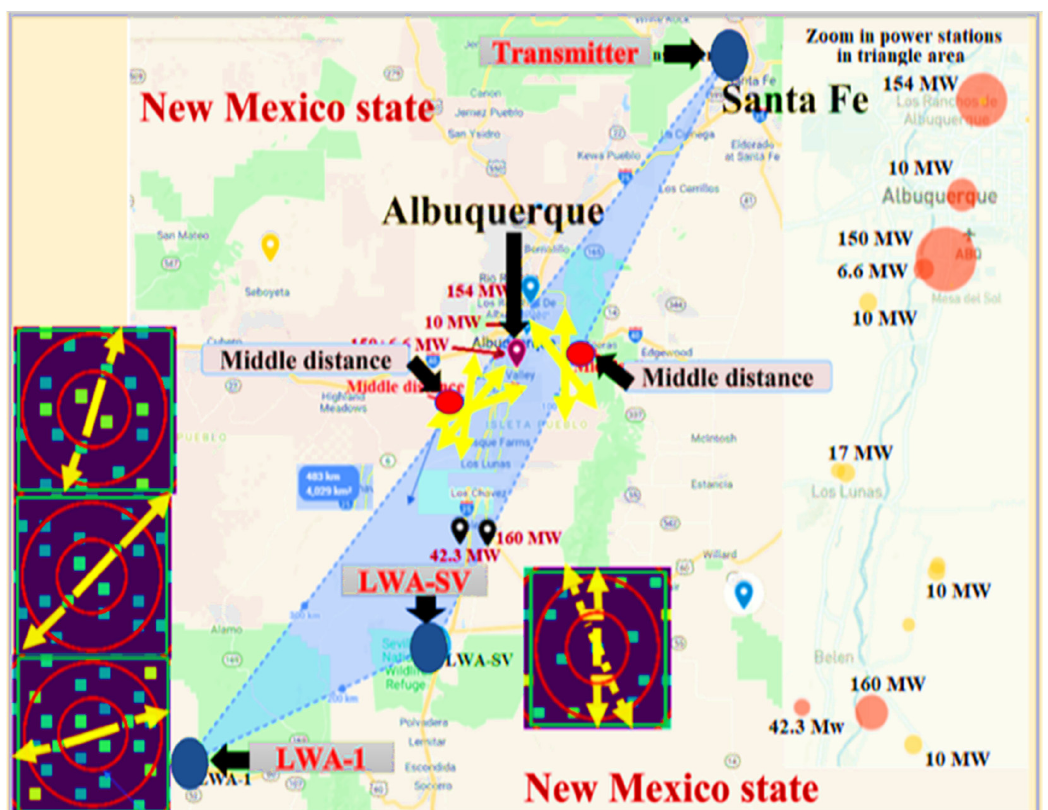
Figure 15. Measured wavevectors at mid-way points (red dots) between Santa Fe and LWA-1 and LWA-SV showing their intersections around Albuquerque and local power generating stations.